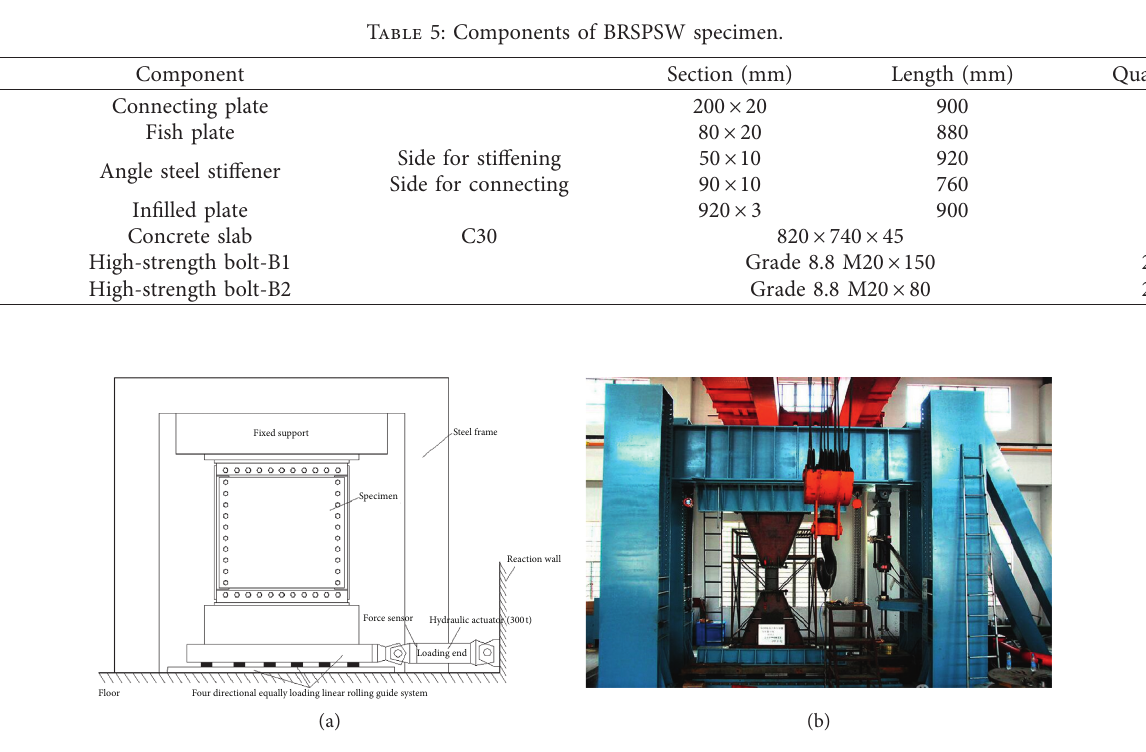
Figure 8: Test setup. (a) Schematic diagram of loading device. (b) Loading